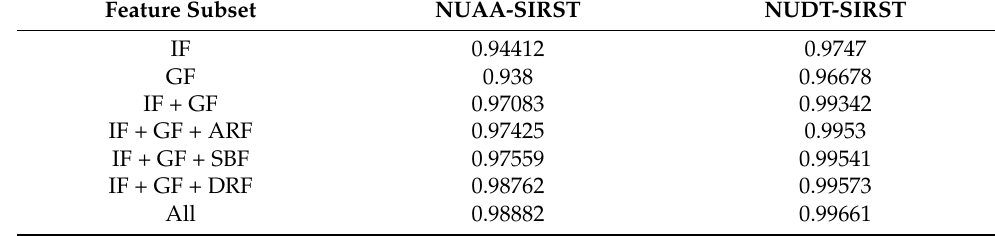
Table 4. Candidate classification results.